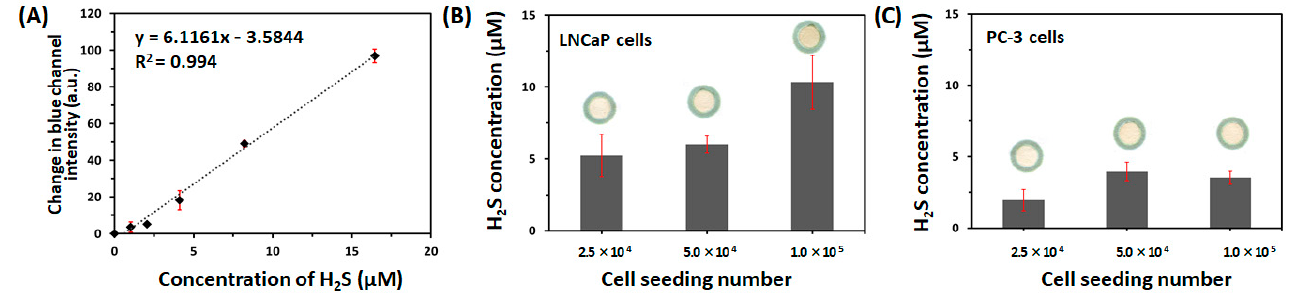
Figure 4. ( A ) Calibration plot of change in blue channel intensity of the H 2 S-sensing paper versus concentration of H 2 S in phosphate-buffered saline at room temperature under ambient conditions ( n = 5). The quantitative analysis of endogenous H 2 S production in two live prostate cancer cell lines ( B ) LNCaP and ( C ) PC-3 cells was performed using the paper-integrated analytical device. The effects of cell number (2.5 × 10 4 , 5.0 × 10 4 , or 1.0 × 10 5 cells/zone) and incubation with L-cysteine (Cys, 5 mM) and L-homocysteine (H-Cys, 1 mM) were assessed after 72 h. The error bars represent standard deviations.